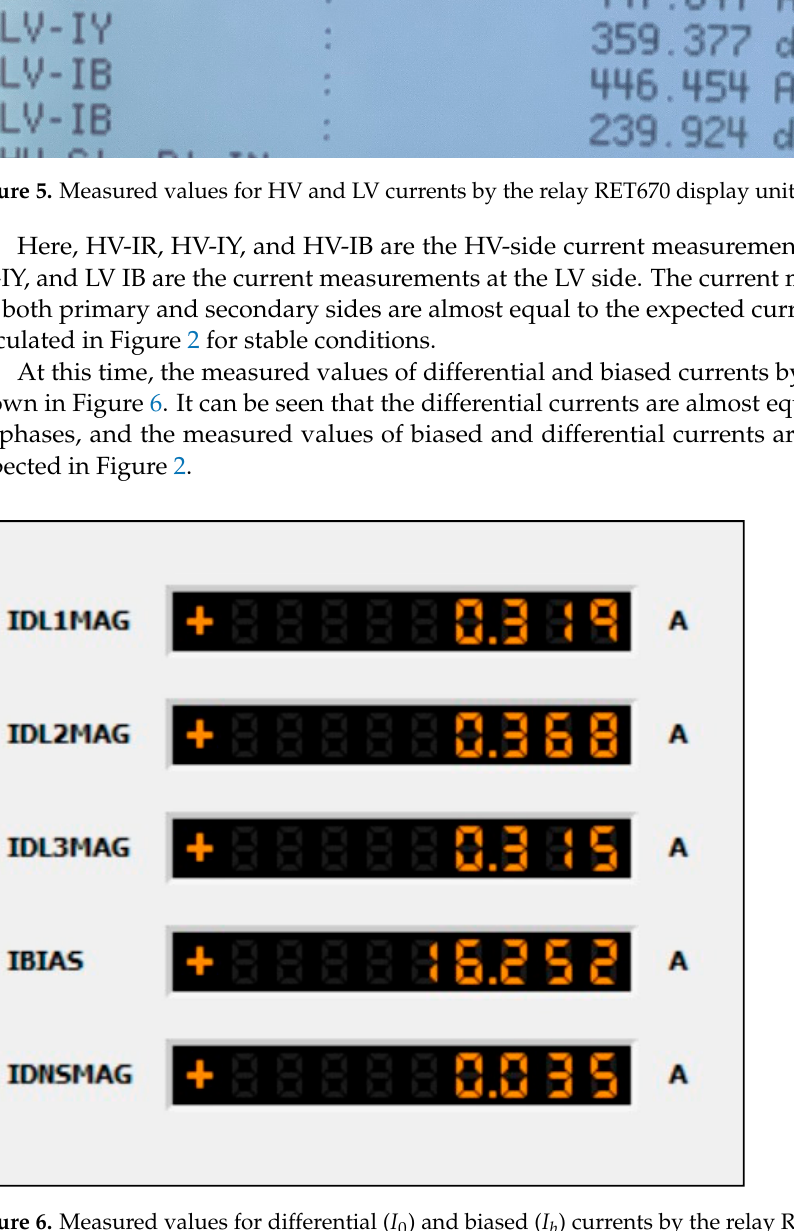
Figure 6. Measured values for differential ( I 0 ) and biased ( I b ) currents by the relay RET670